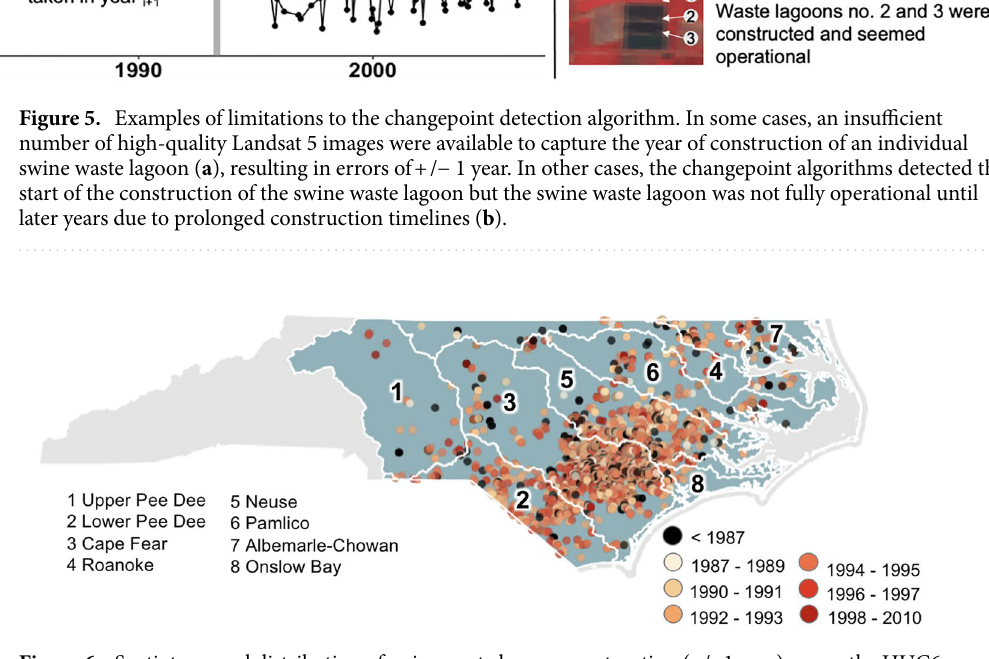
construction for each swine waste lagoon are included in the supplementary material. Most swine waste lagoons were built in the early 90s and prior to the moratorium of 1997. More specifically, 80% of the swine waste lagoons